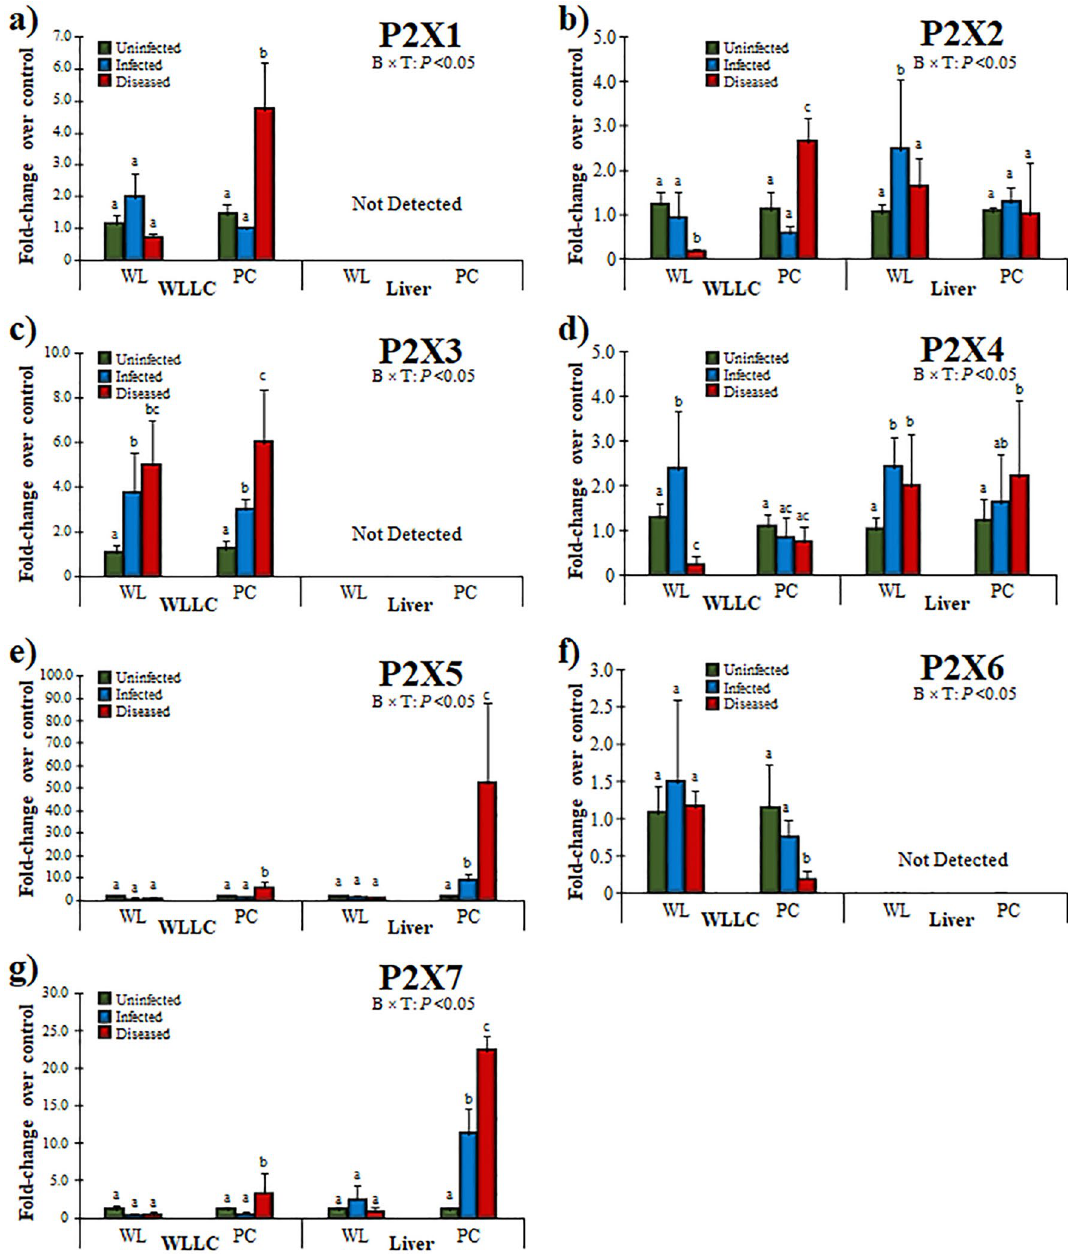
Figure 4. Relative mRNA expression of P2X PRs in the MD-resistant (WL) and -susceptible (PC) chicken lines. PR expression was measured in WLLC and liver samples using RT-qPCR and fold-changes compared to uninfected controls is shown for P2X1 ( a ), P2X2 ( b ), P2X3 ( c ), P2X4 ( d ), P2X5 ( e ), P2X6 ( f ), and P2X7 ( g ). Data and statistics are presented as in Fig.